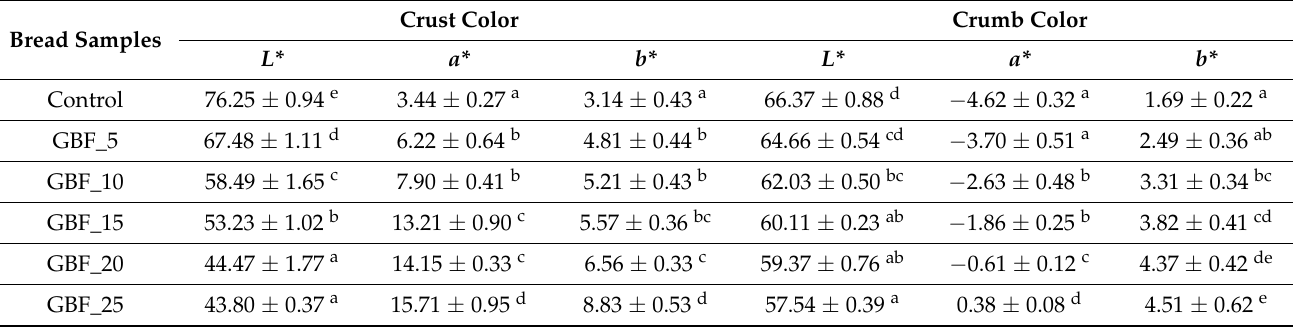
Table 5. Color parameters of the bread samples with different levels of germinated bean flour (GBF) additions. Crust Color Crumb Color Bread Samples L* a* b* L* a* b* Control